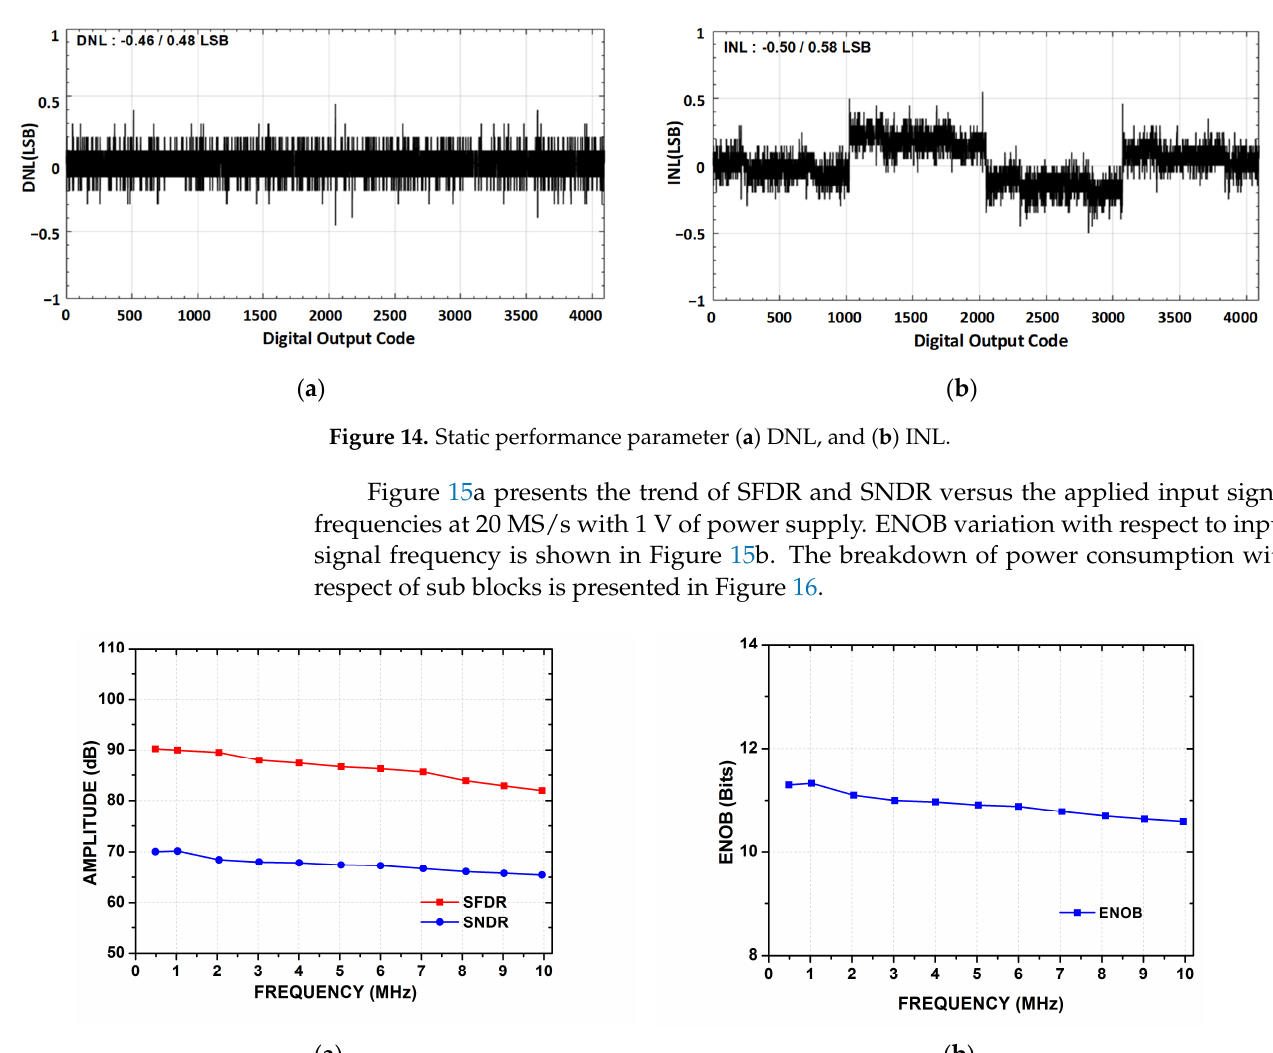
Figure 15. ( a ) Input frequency versus SNDR and SFDR. ( b ) Input frequency versus ENOB.